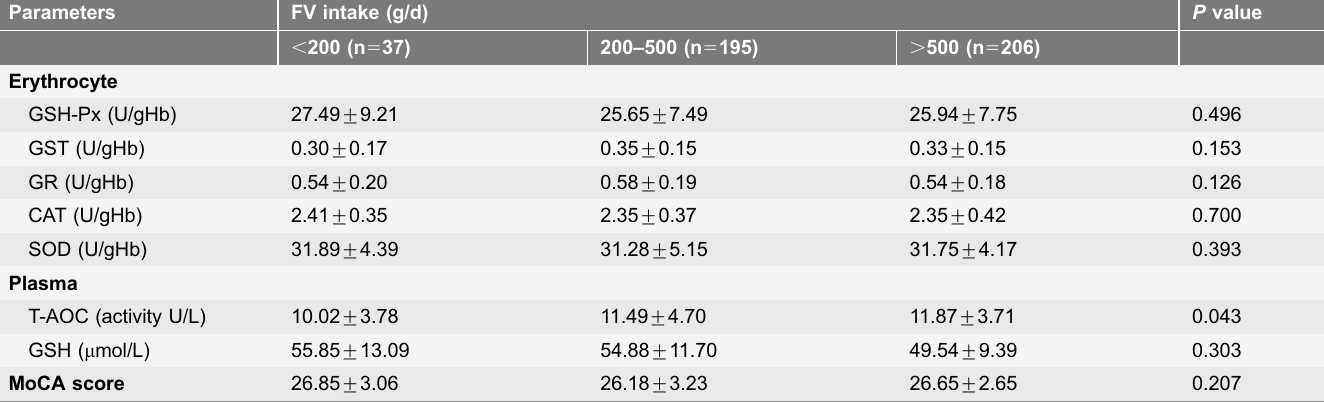
Table 3. Antioxidant parameters and cognitive function according to FV